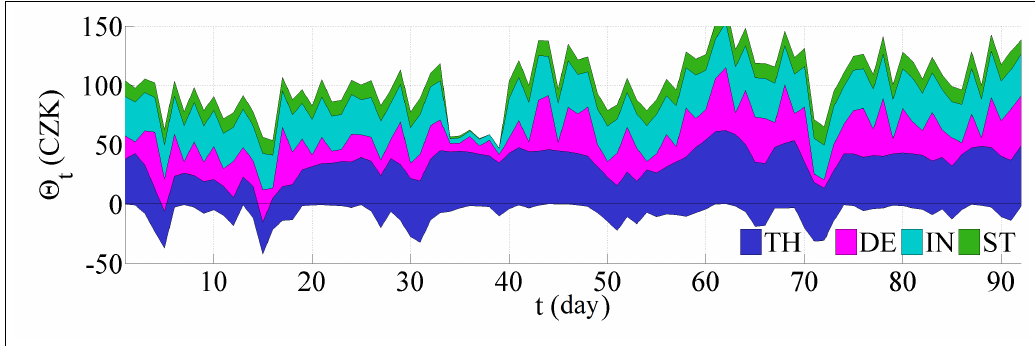
Figure 6. The incremental costs of appliances run during simulation